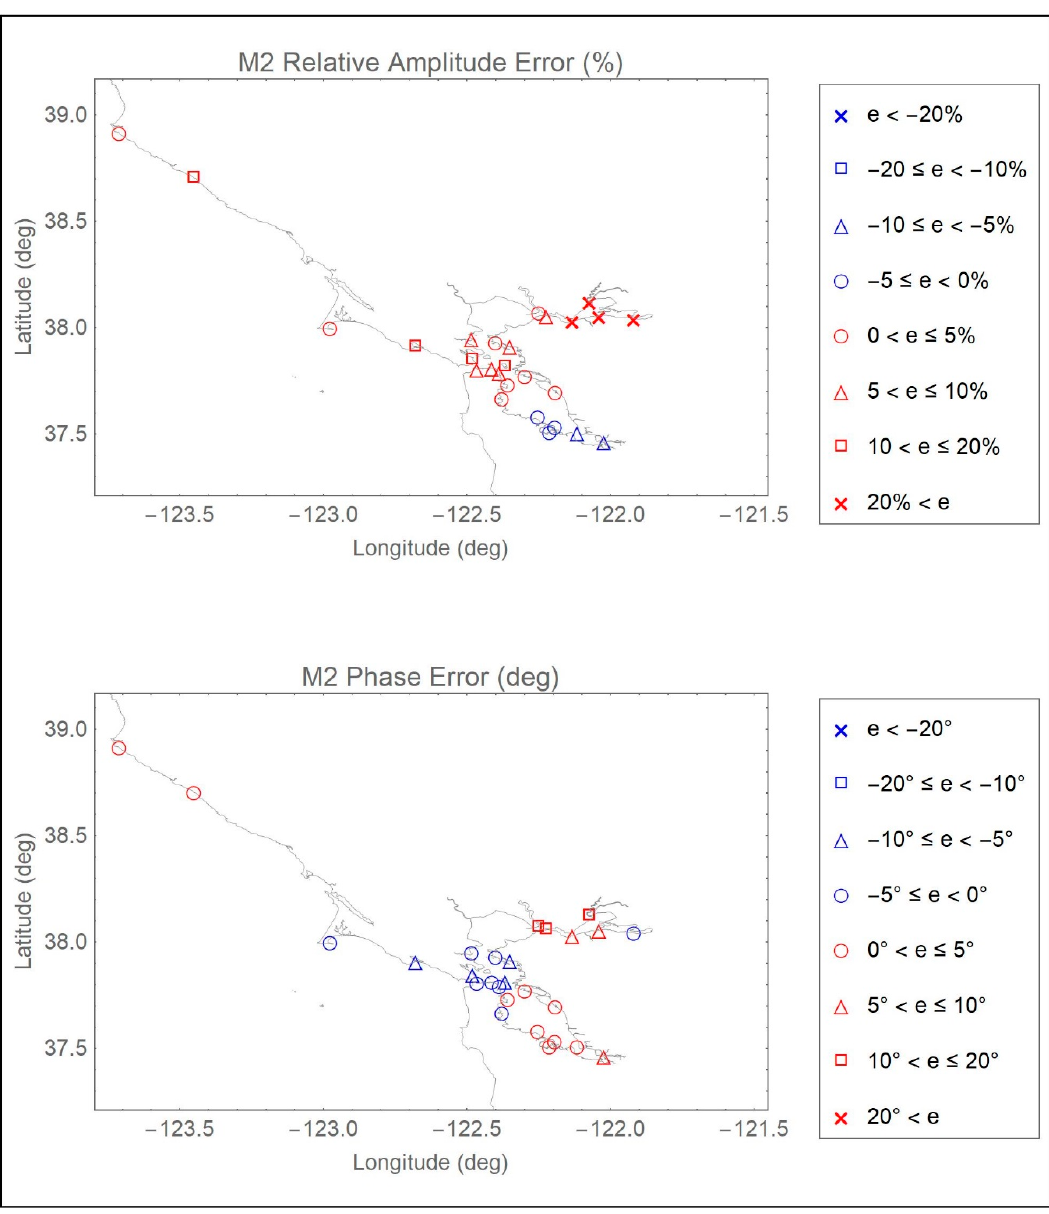
Figure A16. Distribution of ENPAC15 relative amplitude (%) and absolute phase (deg) errors for the M 2 constituent: San Francisco Bay view.